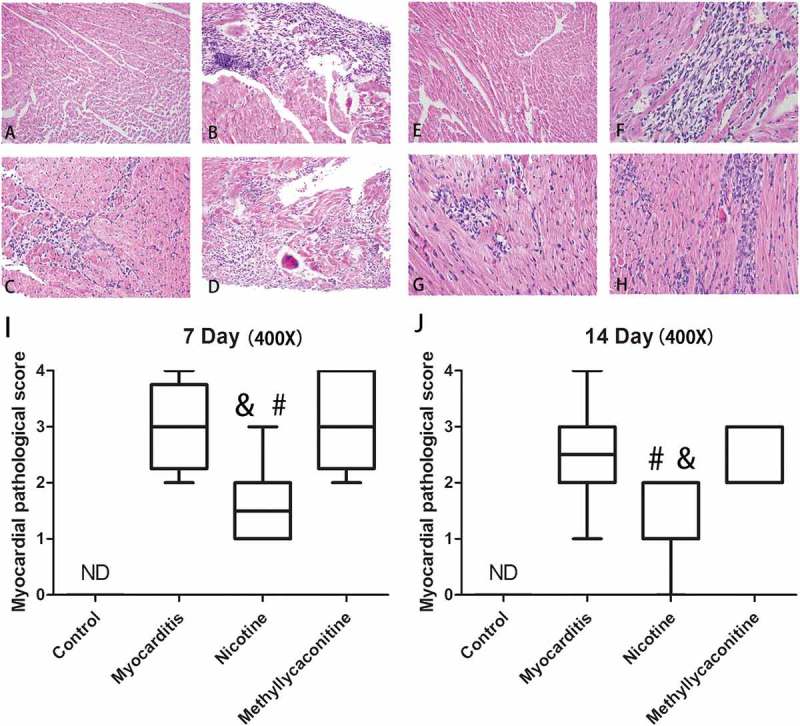
Myocardial histopathology changes for each group (n = 5 in each group). A and E show the lack of histopathology changes for the control group on days 7 and 14; B and F show representative histopathology changes for the myocarditis group on days 7 and 14. Several small foci of cellular infiltrations are shown; C and G show representative histopathological changes for the nicotine group on days 7 and 14. The extent of cellular infiltration was less severe in the nicotine group than in the methyllycaconitine and myocarditis groups; small and limited foci of cellular infiltrations were obtained. D and H show representative histopathological changes for the methyllycaconitine group on days 7 and 14. Several large foci of cellular infiltrations are obtained. I and H are the Box-plots of the histopathology scores for each group on days 7 and 14. The score of the nicotine group was significantly lower than those of the myocarditis and methyllycaconitine groups. &P < 0.05 versus the myocarditis group and #P < 0.05 versus the methyllycaconitine group.